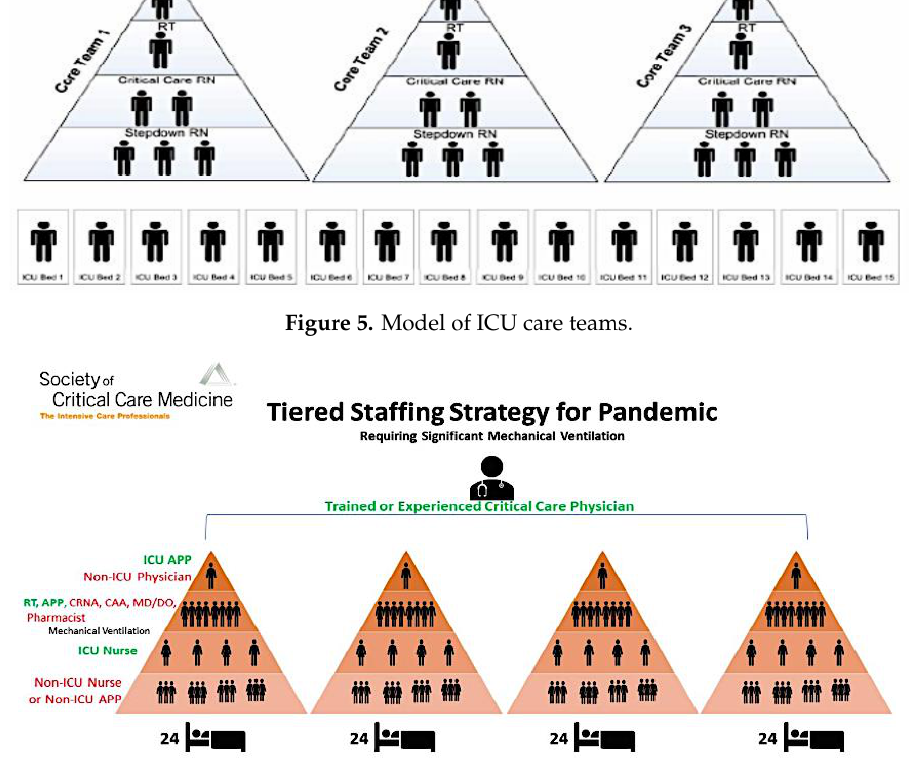
Figure 6. Expanded application of tiered staffing strategy for pandemic.